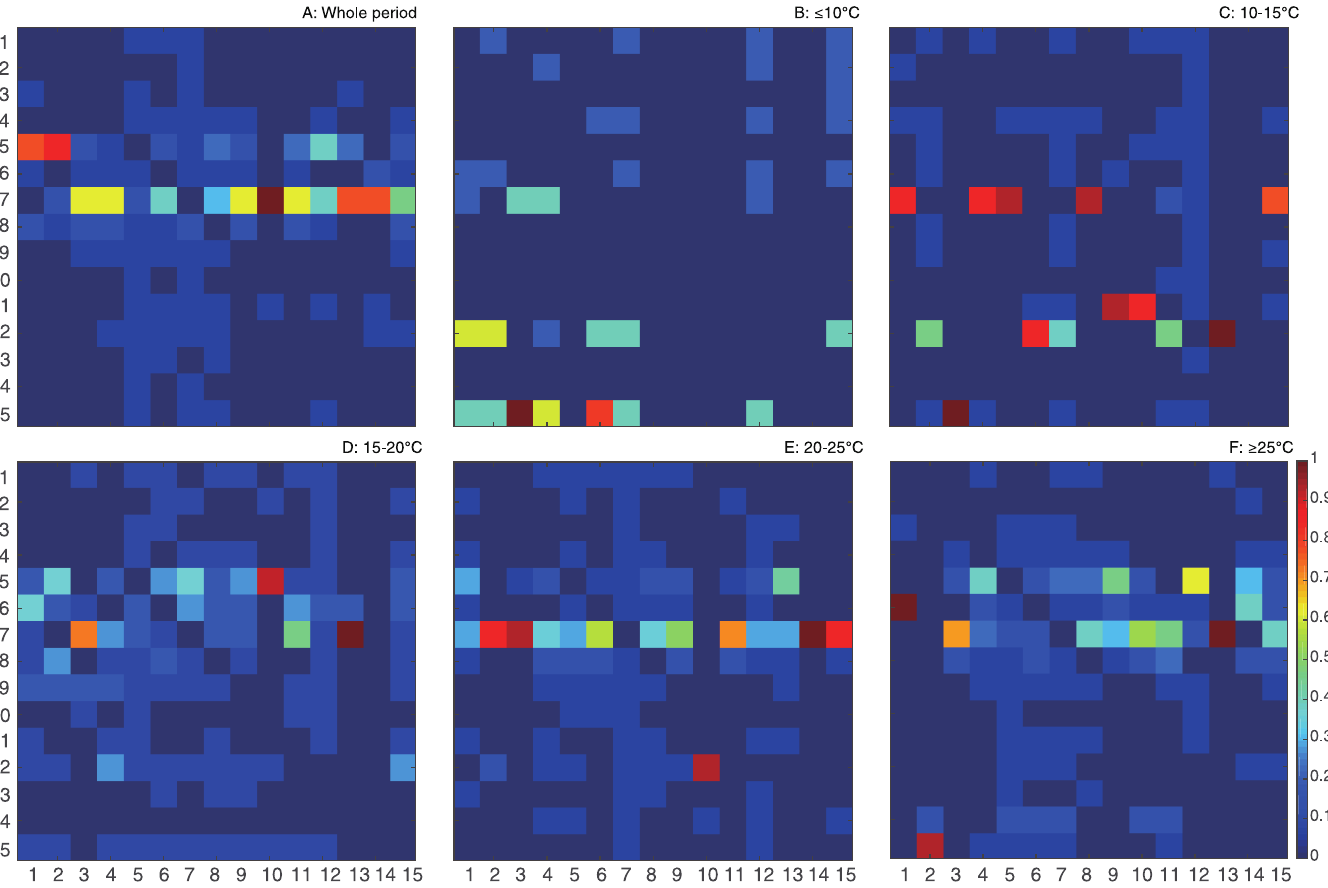
Fig 7. Link salience matrices highlighting Pareto links. Link importance is measured as link salience for all OIF networks corresponding to the whole period and five TRs, yielding 15 × 15 matrices. The values of link salience are normalized to 1, and drawn in plots A, B, C, D, E and F, respectively. Pareto links are between keystone species responsible for the stability of the